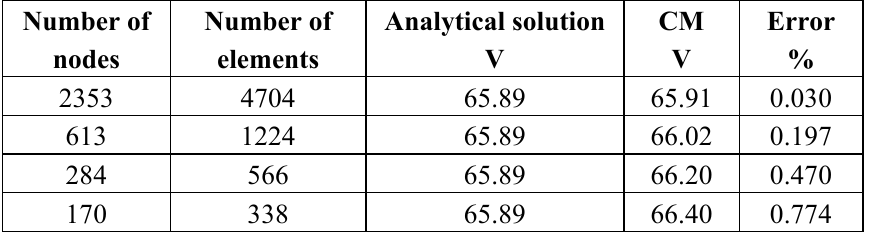
Table 5. Effect of the mesh in the